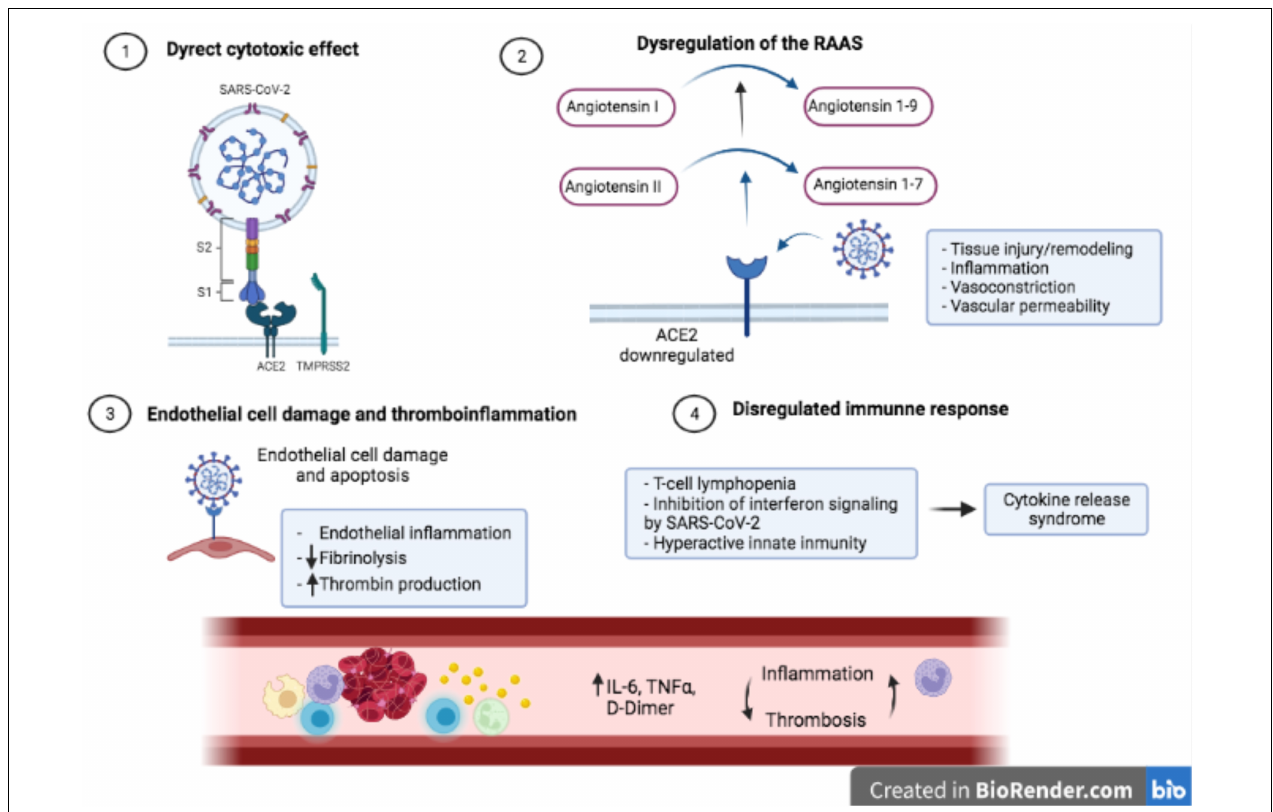
FIGURE 1 | Pathophysiology of COVID-19 [adapted from Gupta et al. (18)]: (1) Direct virus-mediated cell damage. SARS-CoV-2 enters into host cells through the union between the spike protein and ACE2 receptor in the presence of TMPRSS2 protease; (2) Downregulation of ACE2 leads to a dysregulation of the RAAS and consequently to an increase of angiotensin I and angiotensin II; (3) Virus entrance to endothelial cell damage induces apoptosis and endothelialitis; (4) T-cell lymphopenia, inhibition of interferon signaling and hyperactive innate immunity produces a dysregulation of the immune response and a cytokine storm